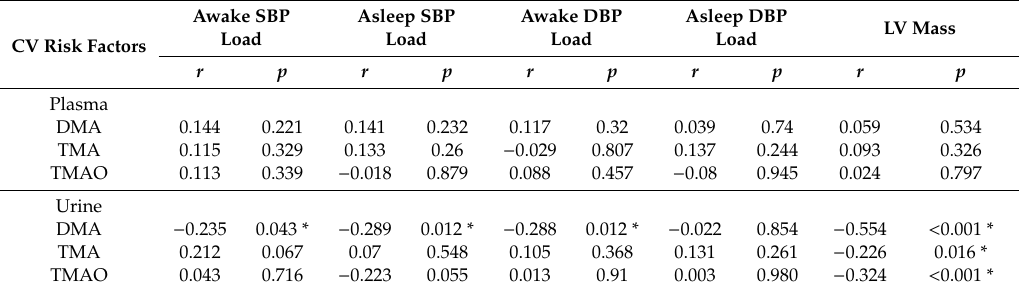
Table 4. Correlation between plasma and urinary methylamines and cardiovascular risk factors in children with CKD stage